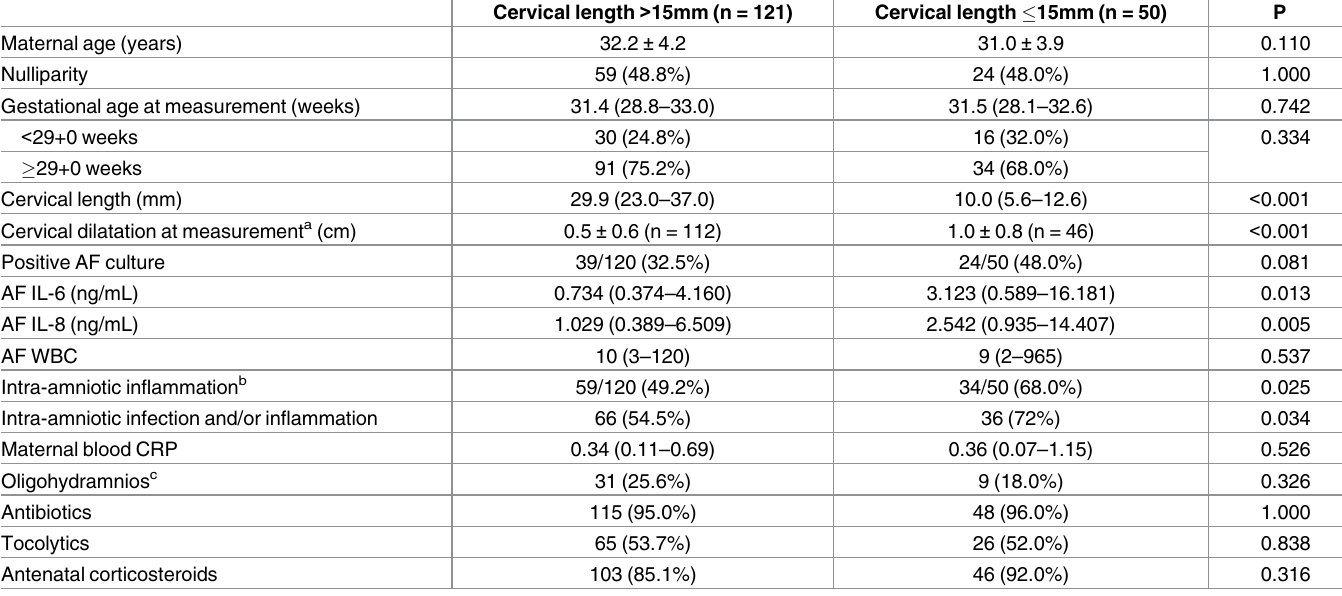
Table 1. Clinical characteristics of the study population according to the presenceor absence of a short